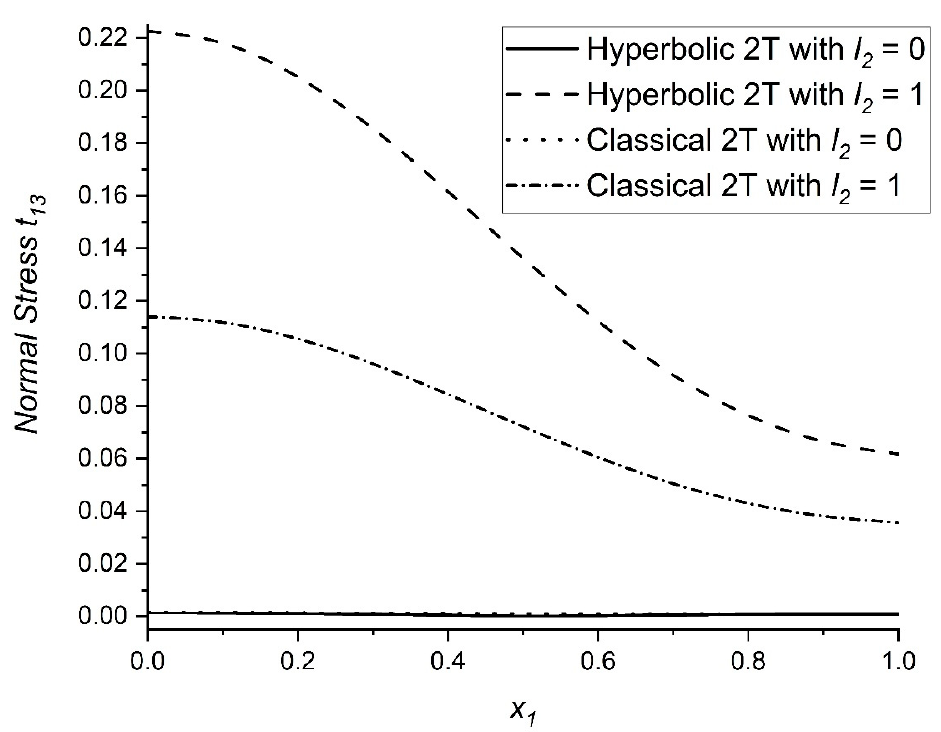
Figure 7. Variations in dimensionless Normal Stress t 13 .